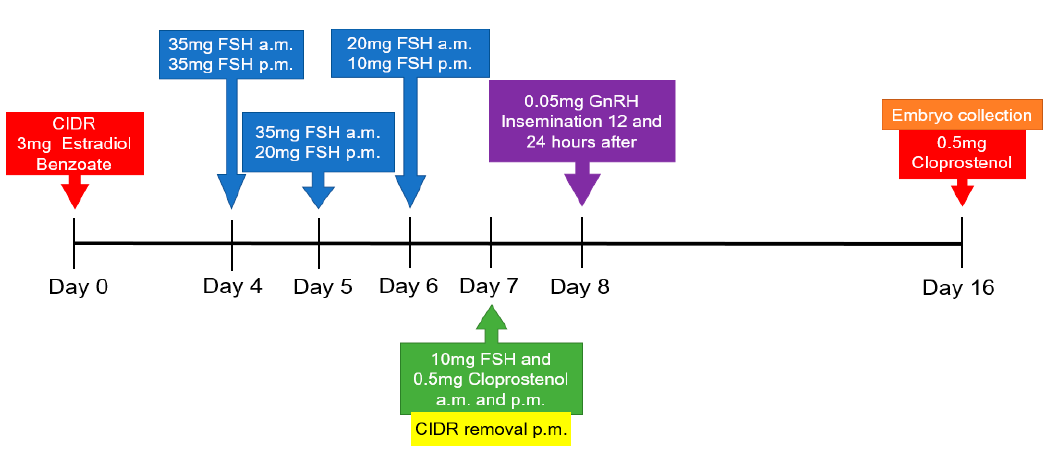
Figure 1. Superovulation (SOV) protocol used in Wagyu cows.